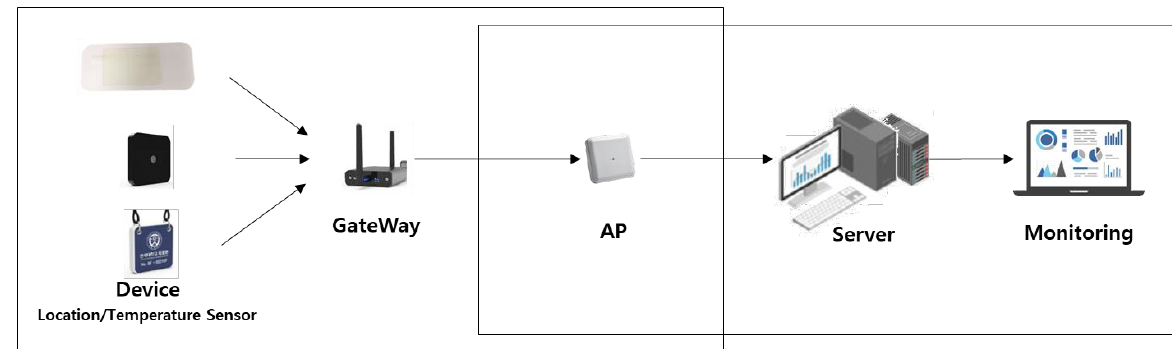
Figure 9. Non-Hospital Network System.